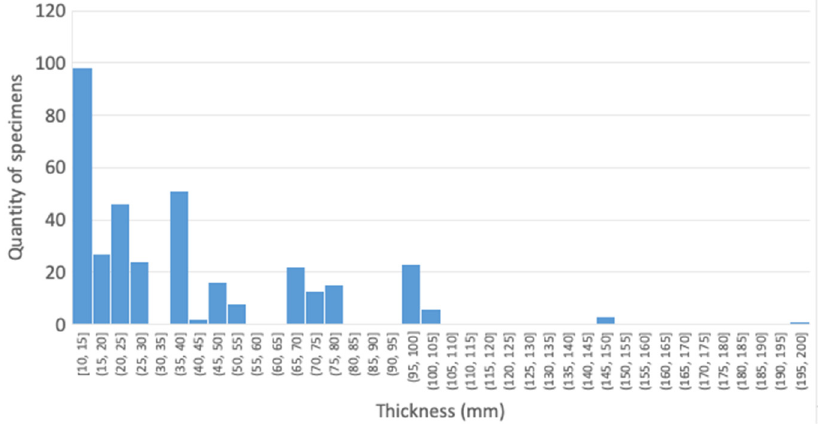
Figure 7. Histogram of thickness with in-air T-joint samples . Figure 5. Histogram of thickness with in-air T-joint